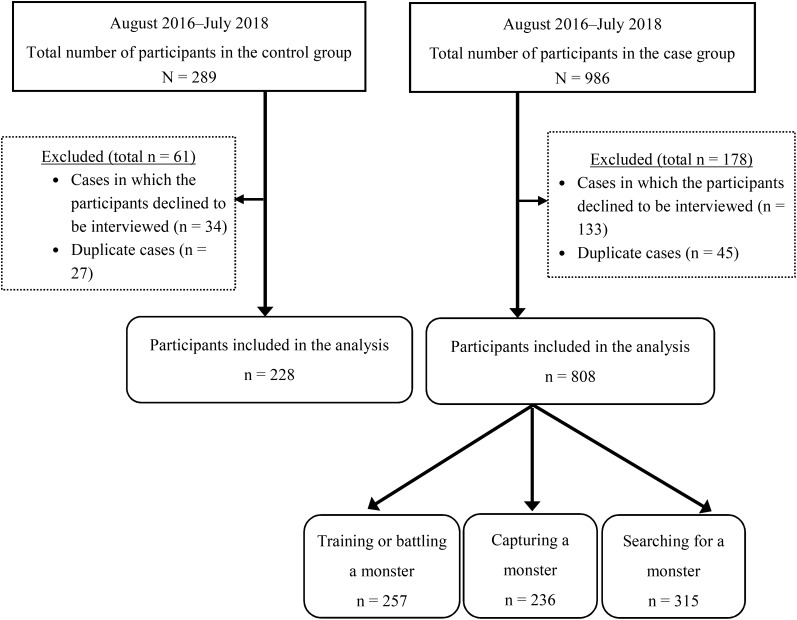
Study flow chart.